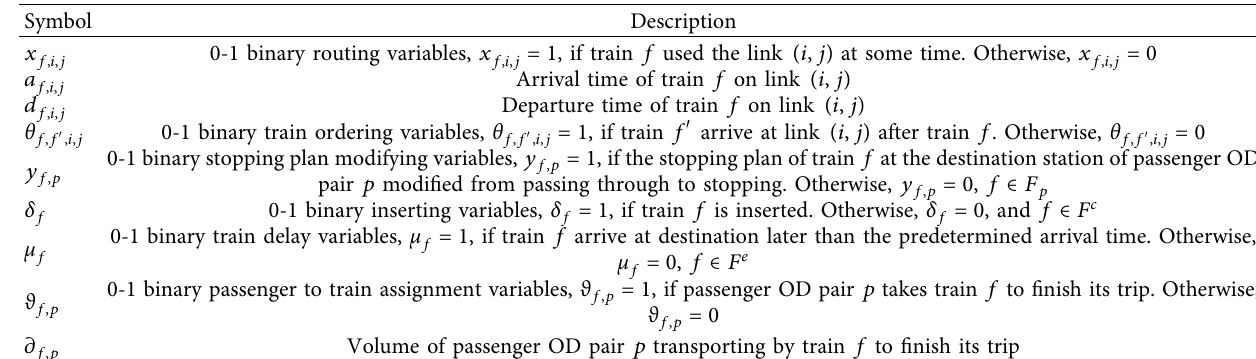
Table 2: Decision